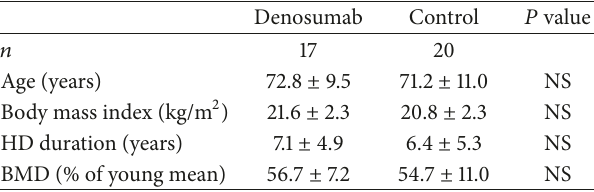
Table 1: Baseline characteristics of the patients.